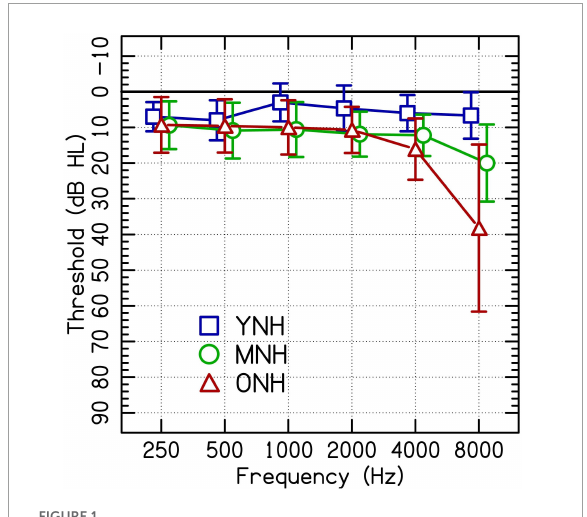
FIGURE1 Group average audiometric thresholds of the test ears of participating listeners with clinically normal hearing at audiometric frequencies between 250 and 4,000 Hz separated into younger (YNH), middle-aged (MNH), and older (ONH) age groups. Error bars are ± 1